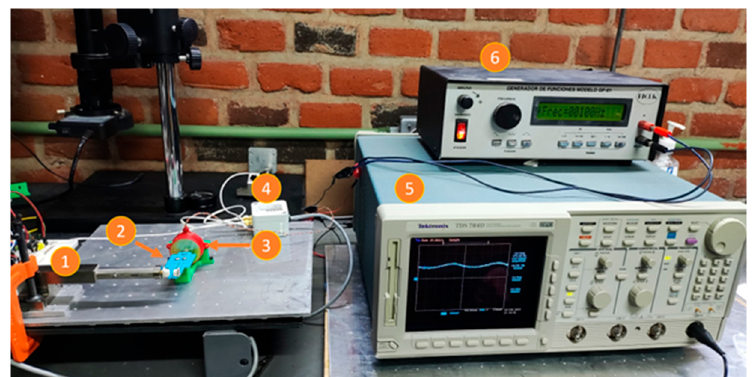
Figure 20. Experimental setup for the frequency test. 1. Inductive sensor. 2. Miniature gripper. 3. Piezoelectric stack. 4. Control module. 5. Oscilloscope Tektronik TDS 784D. 6. Frequency generator.